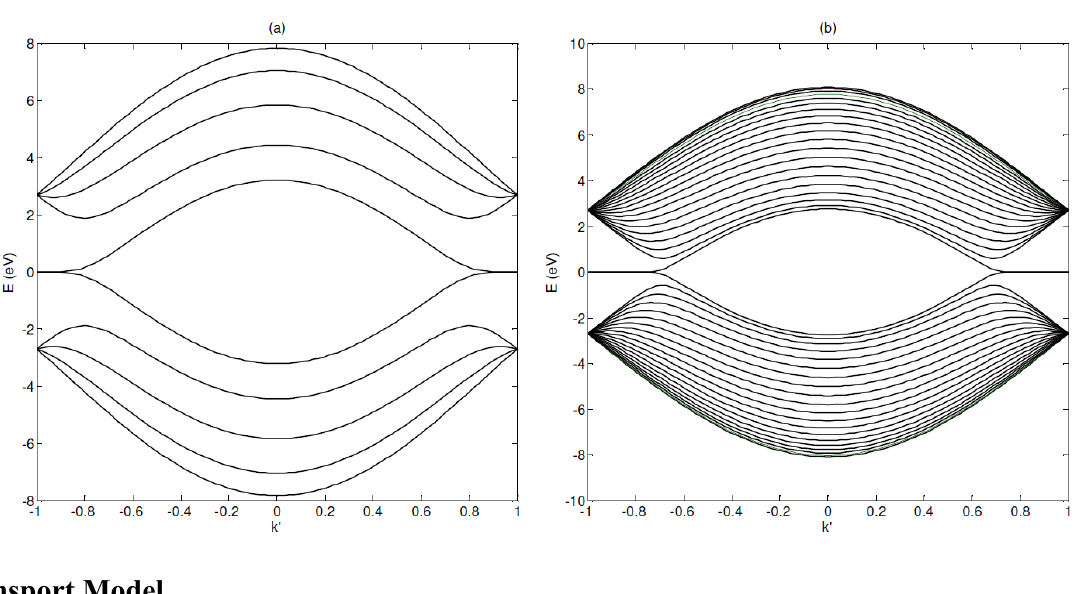
Figure 5. The energy band structure of a zigzag nanoribbon versus the